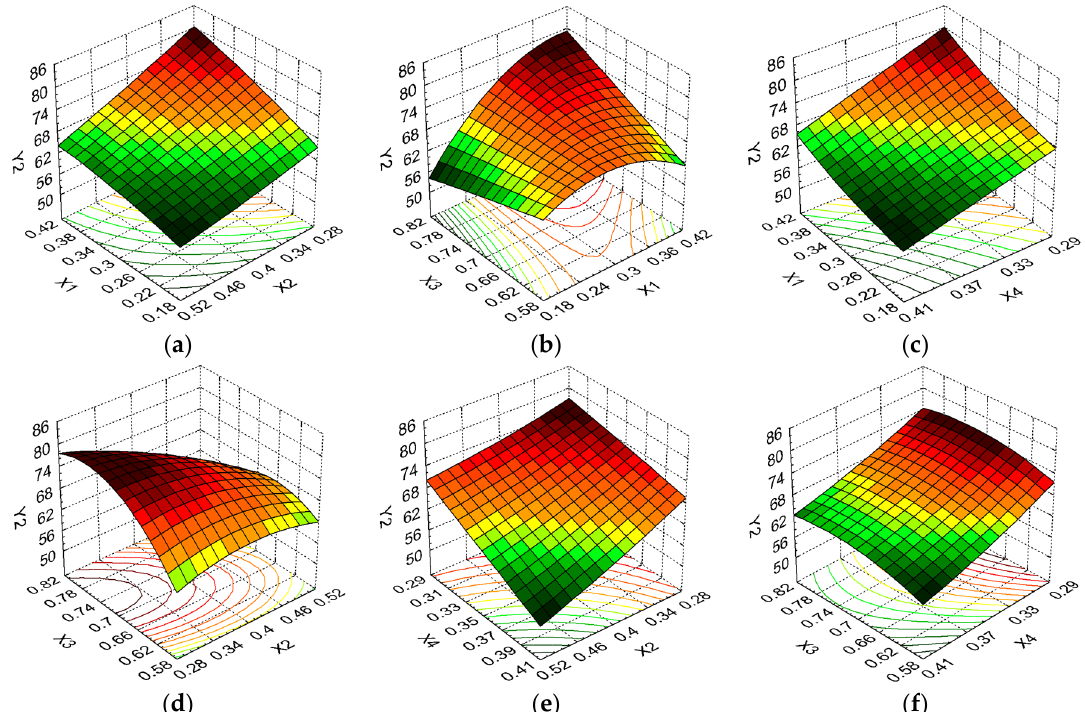
Figure 6. The 3D response surface and contour plot showing the effect of different formulation factors on the microcapsule enzymatic degradation at 2 h ( Y 2 ): ( a ) collagen concentration ( X 1 ) and NaCMC concentration ( X 2 ); ( b ) collagen concentration ( X 1 ) and sodium alginate concentration ( X 3 ); ( c ) collagen concentration ( X 1 ) and doxycycline concentration ( X 4 ); ( d ) NaCMC concentration ( X 2 ) and sodium alginate concentration ( X 3 ); ( e ) NaCMC concentration ( X 2 ) and doxycycline concentration ( X 4 ); ( f ) sodium alginate concentration ( X 3 ) and doxycycline concentration ( X 4 ).